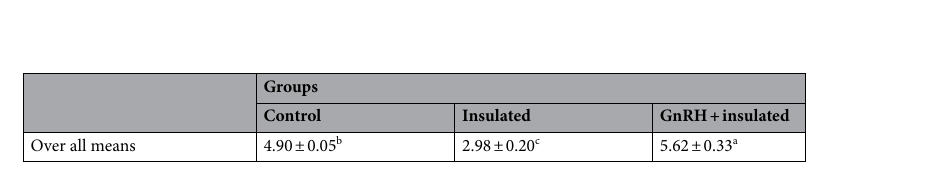
Table 6. the effect of insulation (with and without GnRH injection) and time on the serum concentrations of the testosterone in bucks. a,b,c Means with different small superscript letters in the same row are significantly different ( p < 0.05) (Duncan